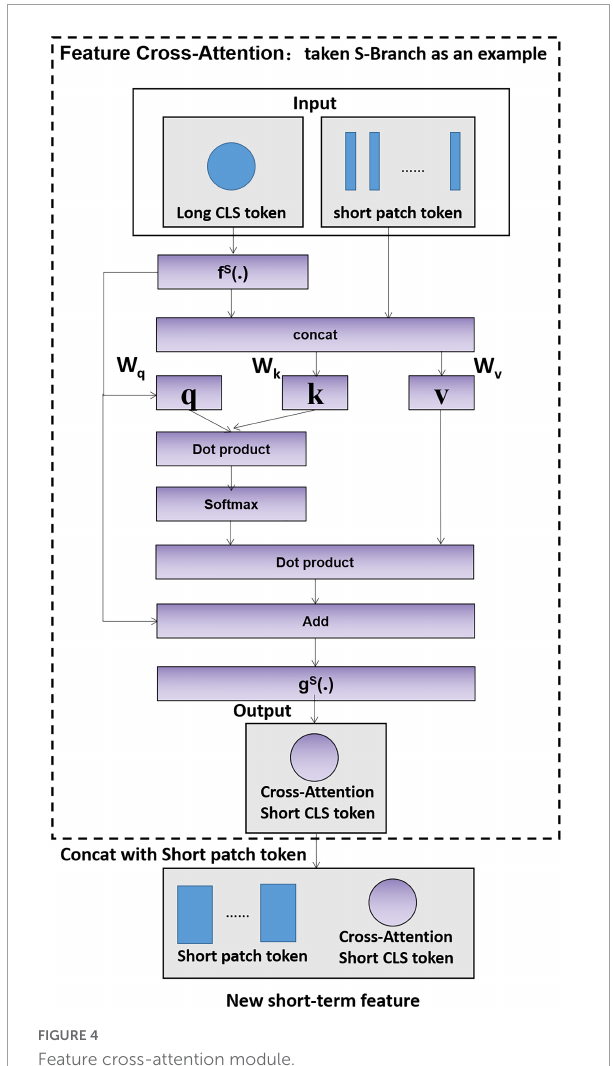
FIGURE4 Feature cross-attention